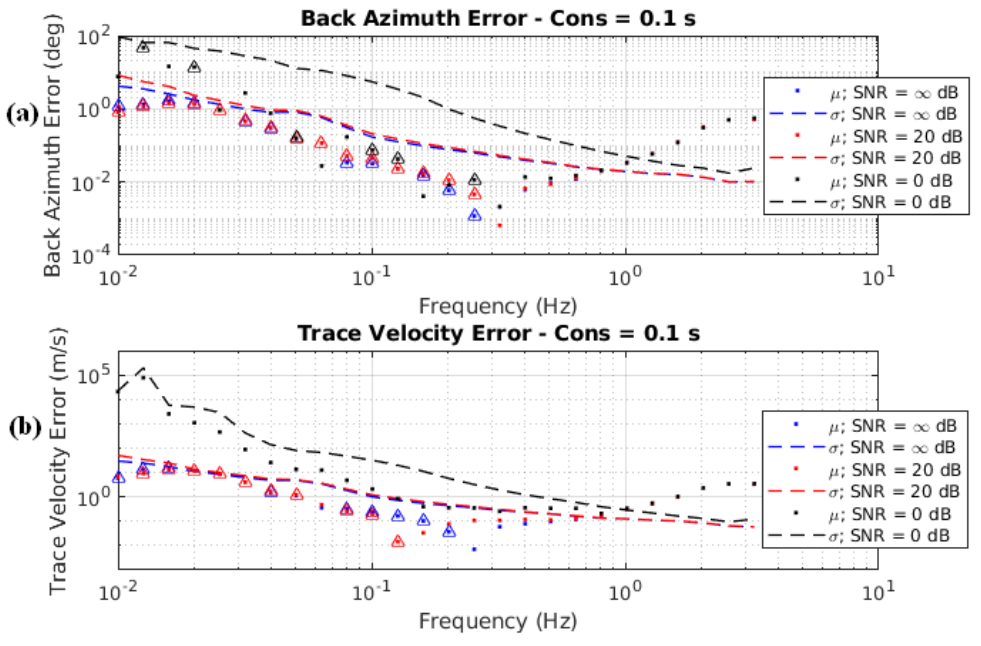
Figure 18. Plots (log-scales) of the ( a ) back azimuth and ( b ) trace velocity mean absolute errors (points) and standard deviations (dashed lines) as functions of frequency, for the case with one defective WNRS. The colors represent the different noise levels; blue is infinite SNR (no noise), red is an SNR of 20 dB, and green is 0 dB. The triangles denote the negative